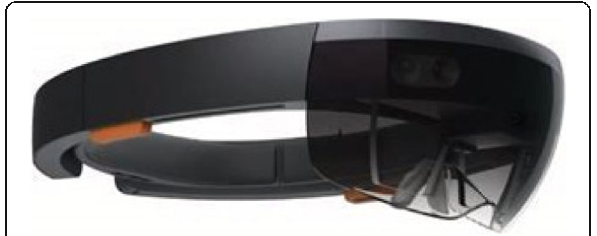
2 HoloLens overview Microsoft